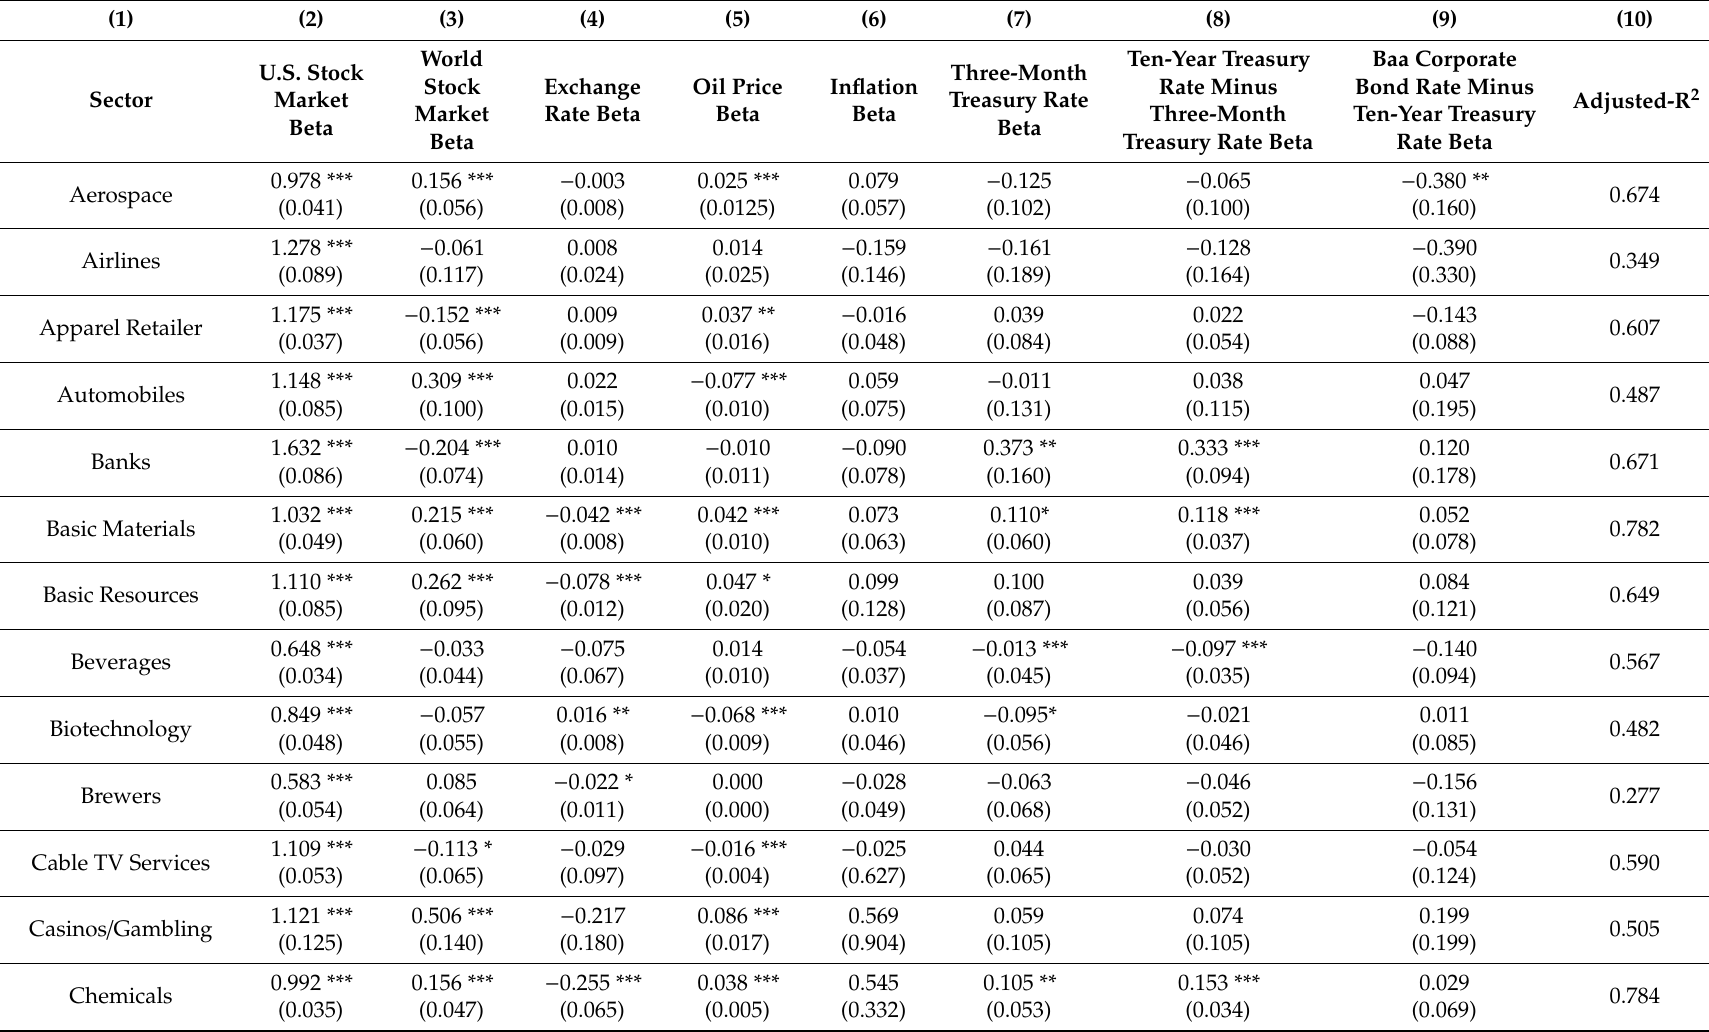
Table 2. The exposures of industry portfolios to macroeconomic